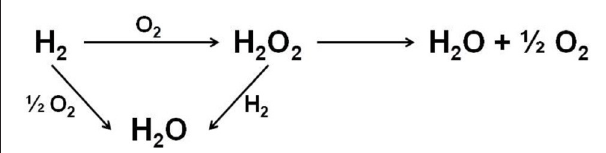
FIGURE 1 | A general scheme of reactions involved in the direct H 2 O 2 synthesis